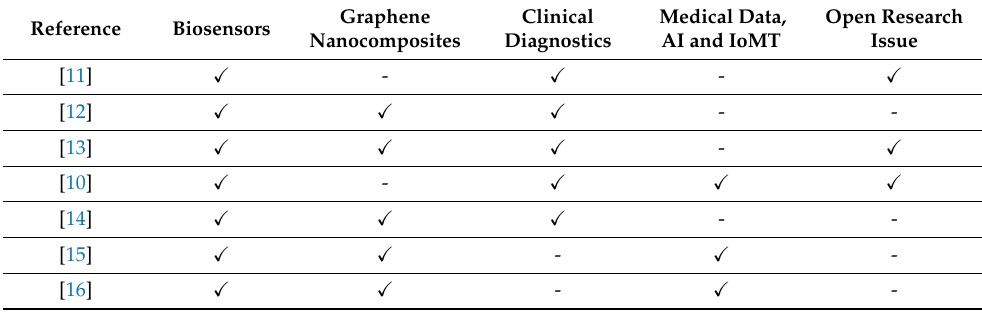
Table 1. Comparison with similar